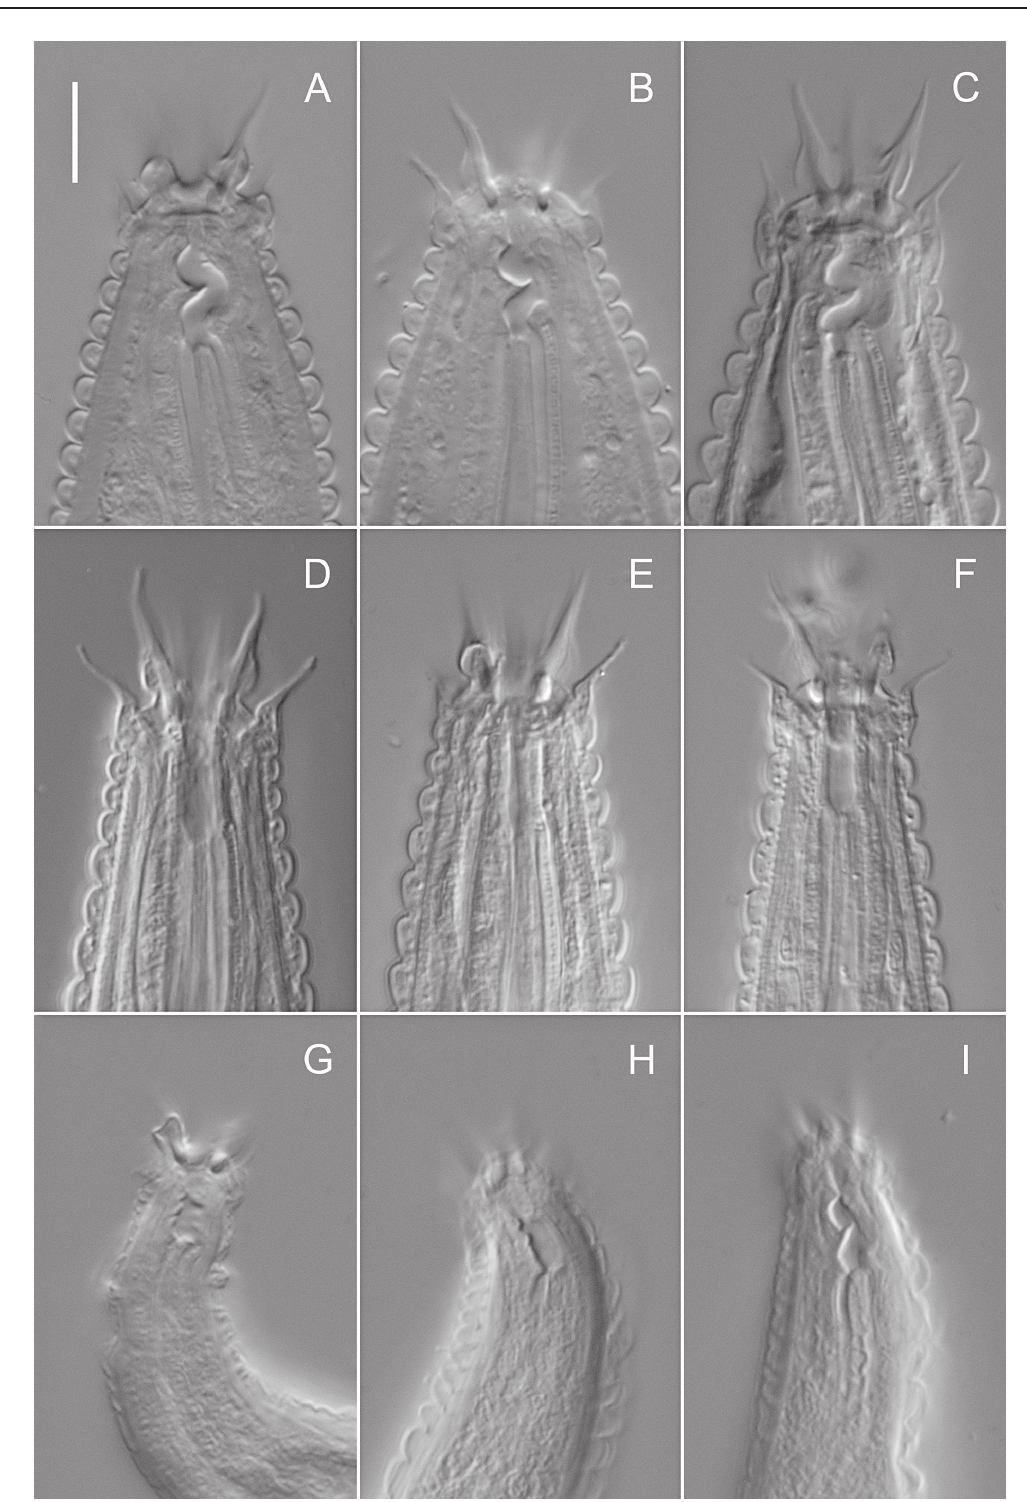
Fig. 3. A–C . Paracrobeles kelsodunensis sp. nov. LM micrographs. A . Male anterior end, ventral side to the right. B–C . Female anterior end, ventral side to the right. D–H . Paracrobeles mojavicus Taylor, Baldwin & Mundo-Ocampo, 2004. D–F . Female anterior end, ventral side to the right. G–H . Male anterior end, ventral side to the right. I . Paracrobeles cf. kelsodunensis sp. nov., male anterior end, ventral side to the right. Scale bar: A–I = 10